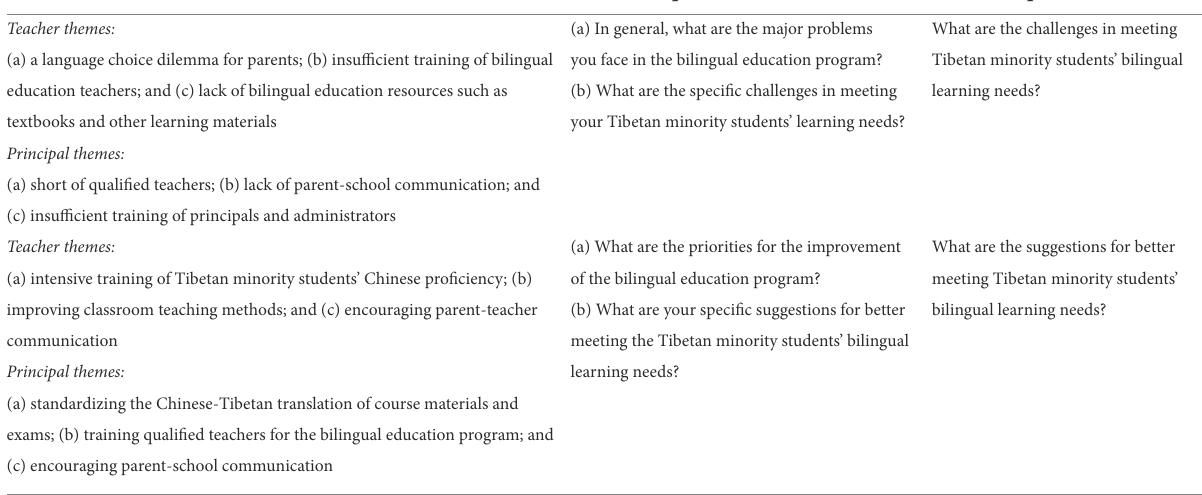
TABLE 2 A summary of teacher and principal interview